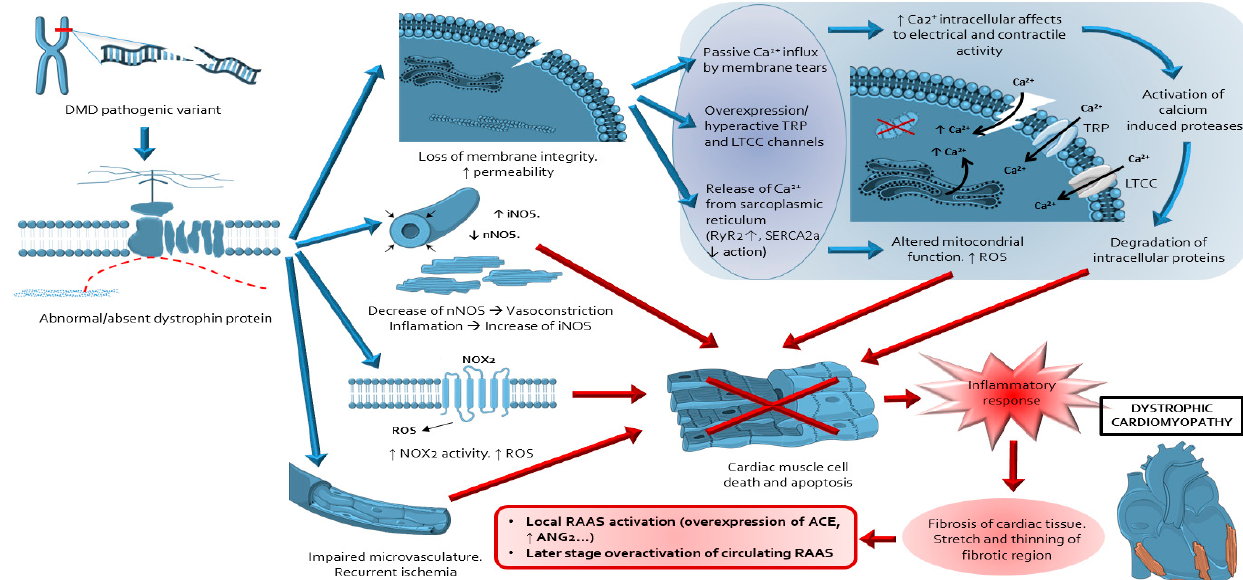
Figure 1. Schematic representation integrating the main pathophysiological mechanisms involved in the cellular damage, cell death and subsequent inflammatory response, fibrosis and RAAS activation in dystrophic deficient cardiomyopathy. (1) Loss of membrane integrity, which causes a calcium leak to cytosol by passive influx, action of ion channels (TRP/LTCC) or release of calcium from SR. (2) Activation of proteases; with degradation of intracellular proteins; (3) Dysregulated nNOS expression and increase of iNOS expression; (4) Mitochondrial dysfunction and increased activity of NOX2 with production of ROS. These products cause mitochondrial damage and cell death. (6) Probable impaired microvasculature with recurrent ischemia may be one of the causes of cardiac muscle cell, apoptosis and fibrosis [34,35]. (7) Activation of local and circulating RAAS after accumulating cardiomyocyte necrosis occurs, perpetuating the fibrotic process. Abbreviations: ACE: angiotensin-converting enzyme; iNOS: inducible nitric oxide synthase; LTCC: L-type Ca2+ channels; nNOS: neuronal nitric oxide synthase; NOX2: NADPH oxidase 2; RAAS: renin–angiotensin–aldosterone system; ROS: reactive oxygen species; TRP: transient receptor potential; RyR2: Ryanodine receptor 2; SERCA2: Sarcoplasmic/endoplasmic reticulum calcium ATP-ase.